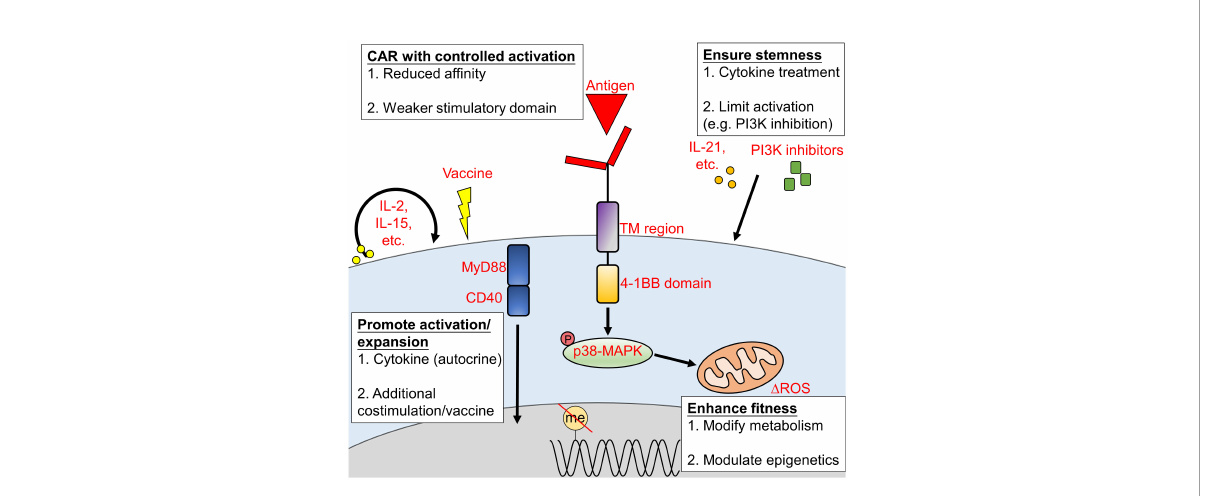
FIGURE 2 Approaches to promote CAR-T cell persistence in vivo. The persistence of CAR-T cells during treatment is crucial to achieve a durable and long-lasting outcome. CAR-T cell persistence can be extended via (1) the promotion of CAR-T cell activation or expansion; (2) enhanced CAR-T cell fi tness; (3) proper CAR construct design and (4) increased CAR-T cells stemness. TM, transmembrane; ROS, reactive oxygen